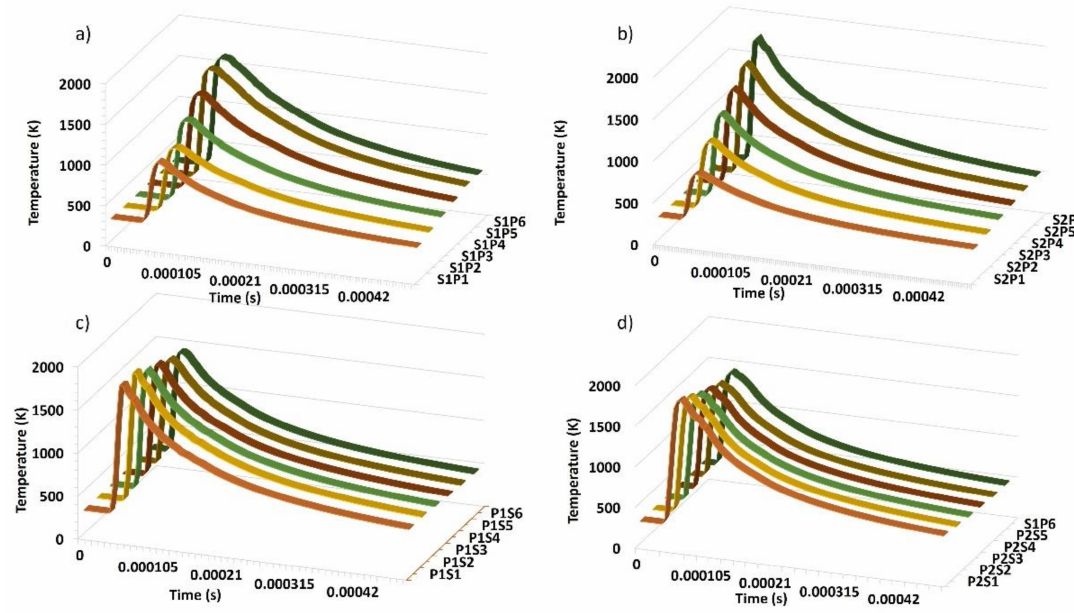
Figure 5. Temperature profiles: ( a ) S1P1 to S1P6, ( b ) S2P1 to S2P6, ( c ) P1S1 to P1S6, and ( d ) P2S1 to